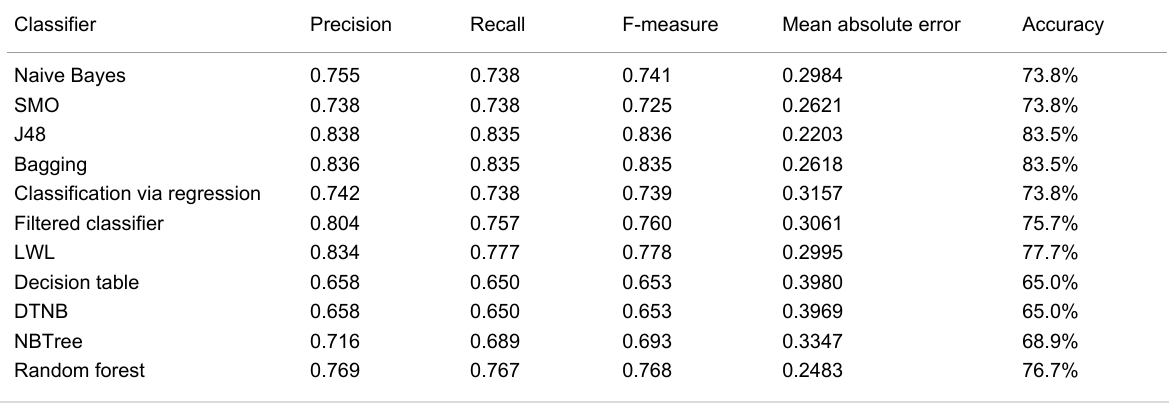
Table 4: Results from the 10-fold cross-validation listed by classifier for the fourth analysis including the expert-selected molecular descriptors with cytotoxicity concentration. See Equation 1–4 for the definition of precision, recall, F-measure, and mean absolute error and accuracy. Classifier